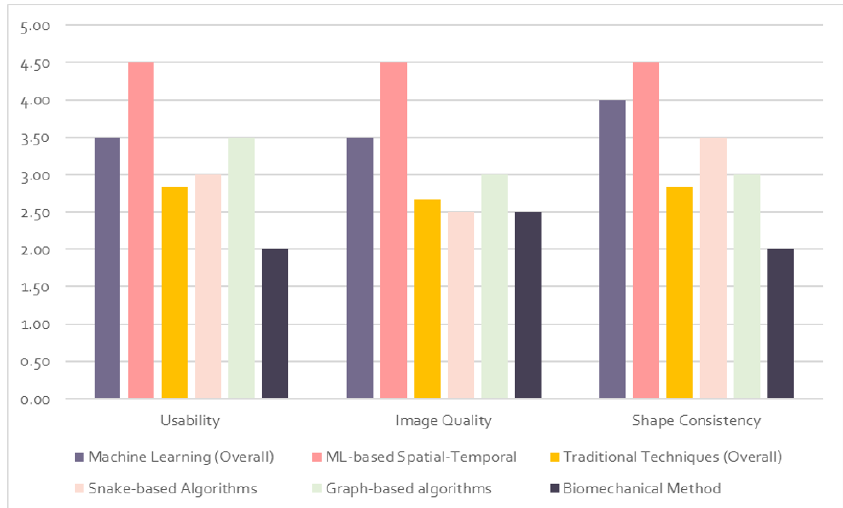
Figure 8. Bar chart for the total qualitative score of tongue image segmentation categories. The Y-axis is the qualitative score probability, and the X-axis is the quality score category for each image segmentation